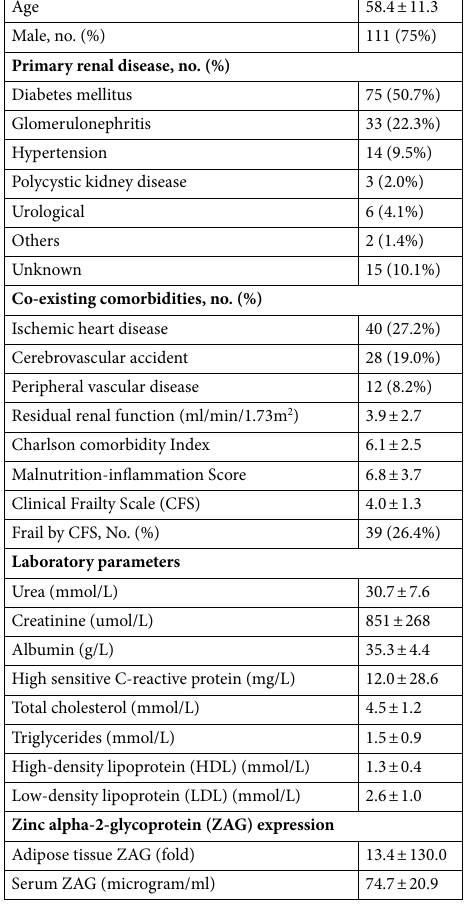
Table 1. Clinical and biochemical characteristics. Data are expressed as mean ± standard deviation.